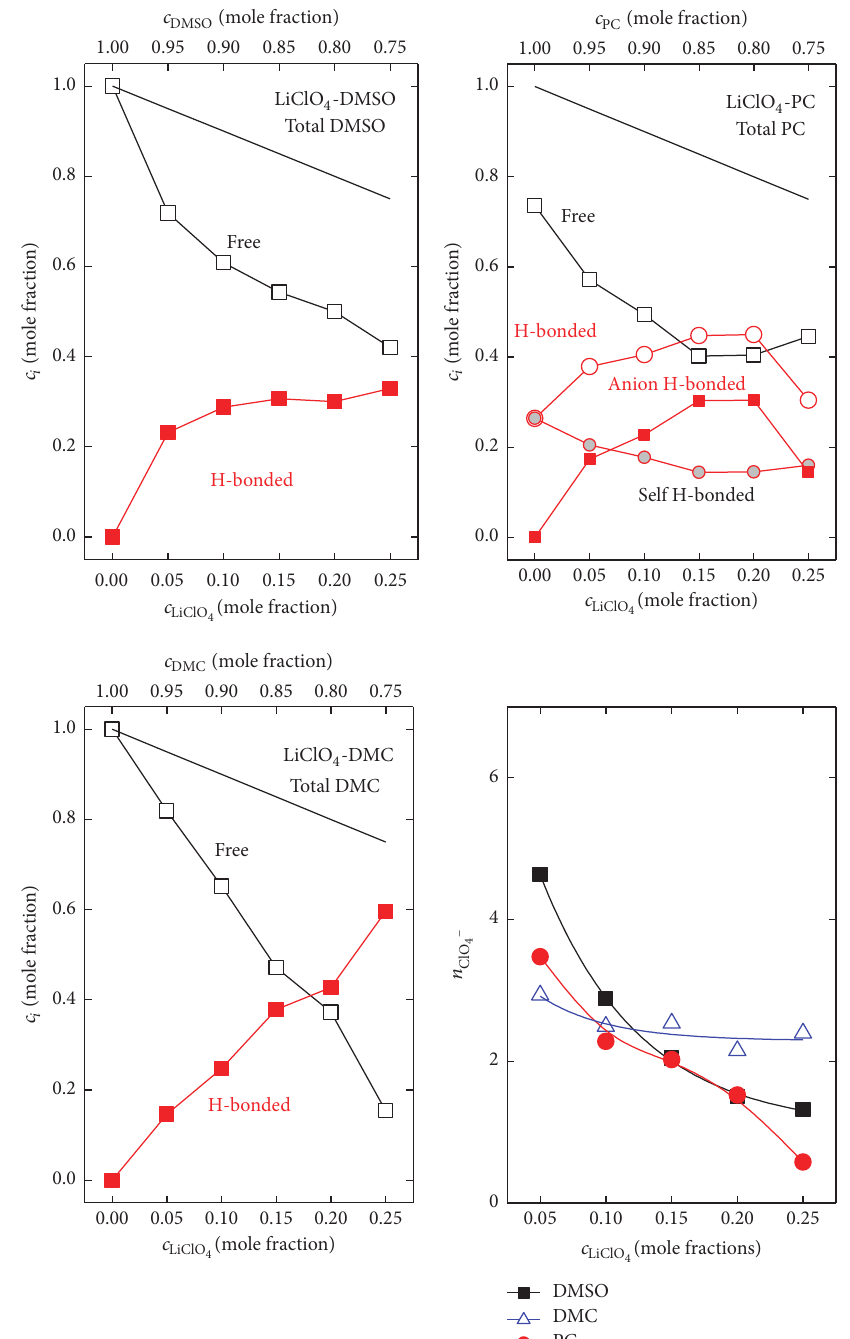
Figure 5: Concentration dependence of the amount of free and H-bonded molecules and mean number of the solvent molecules bonded to anions of the solvent in ionic solutions of DMSO, PC, and